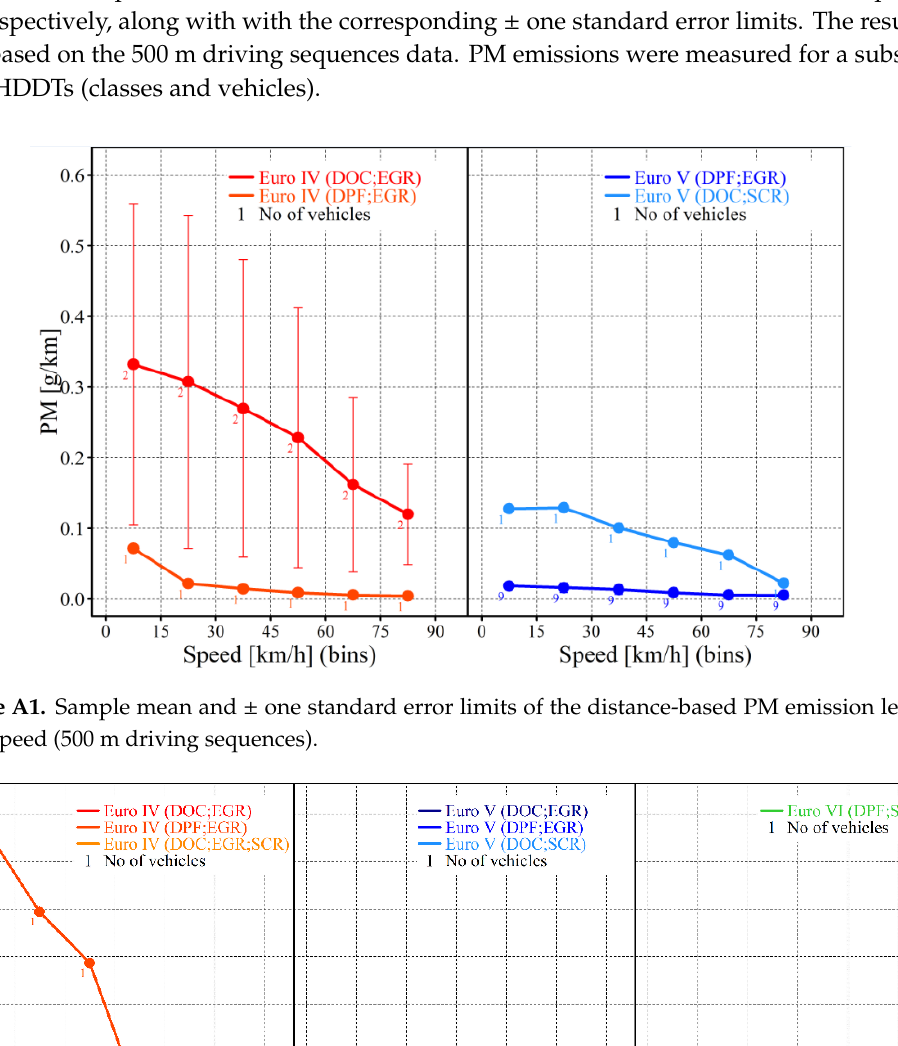
Figure A3. Sample mean and ± one standard error limits of the distance-based CO emission levels over speed (500m driving sequences). Figure A4. Sample mean and ± one standard error limits of the distance-based FC levels over speed (500m driving sequences). Appendix B